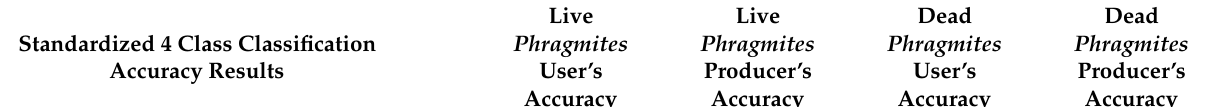
Table 6. User’s and Producer’s accuracy metrics for each study